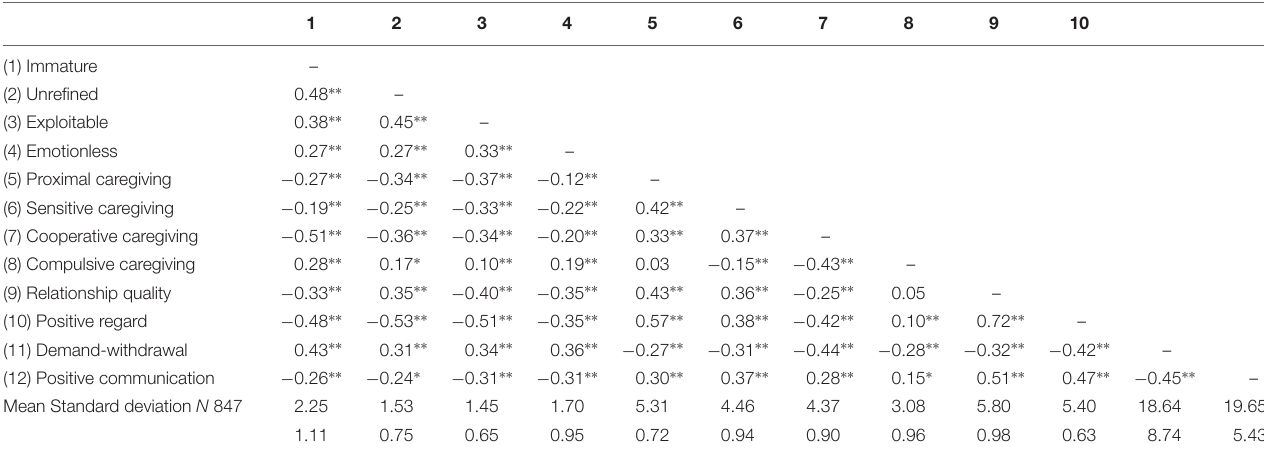
TABLE 4 | Study 2 descriptive statistics and zero-order correlations between the perpetration version of the DIRRS and other study